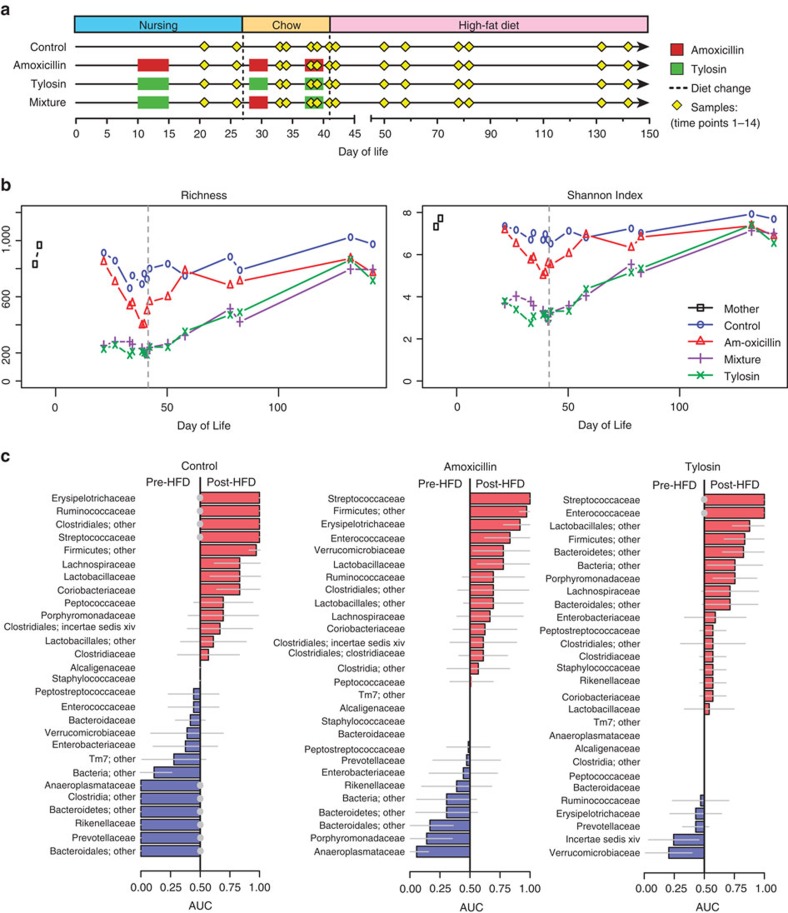
Ecological outcomes from early-life PAT and response to dietary intervention.(a) Experimental design and timing of microbiota samples. (b) α-diversity measured at a coverage depth of 3,000 sequences per sample. (c) Differentiating bacterial families immediately before and after introduction of HFD. Area-under-curve (AUC) with 95% confidence intervals (grey lines) for differentiating pre-HFD and post-HFD mice is plotted by treatment group in major families (>1% relative abundance in at least one mouse). Significantly predictive results (Mann–Whitney test) after false-discovery rate correction (q<0.05) are indicated by grey-filled circles.